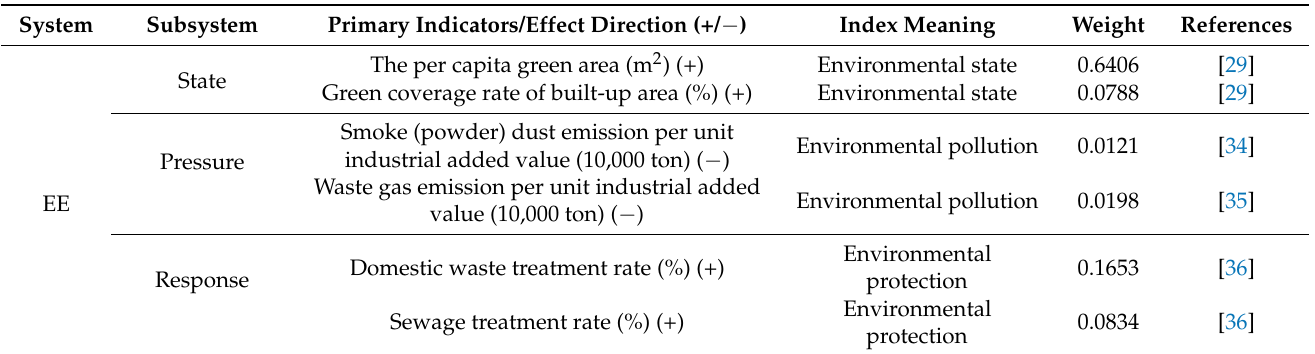
Table 1. Evaluation index system of EE and